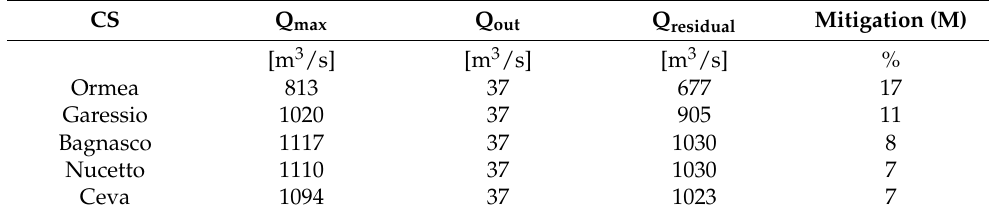
Table 10. The mitigation effect of the single Tanarello River dam if it had a height of 30 m; the outgoing flow rate, calculated to optimize the efficiency of the retention dam using Equation (4), is equal to 37 m 3 /s.